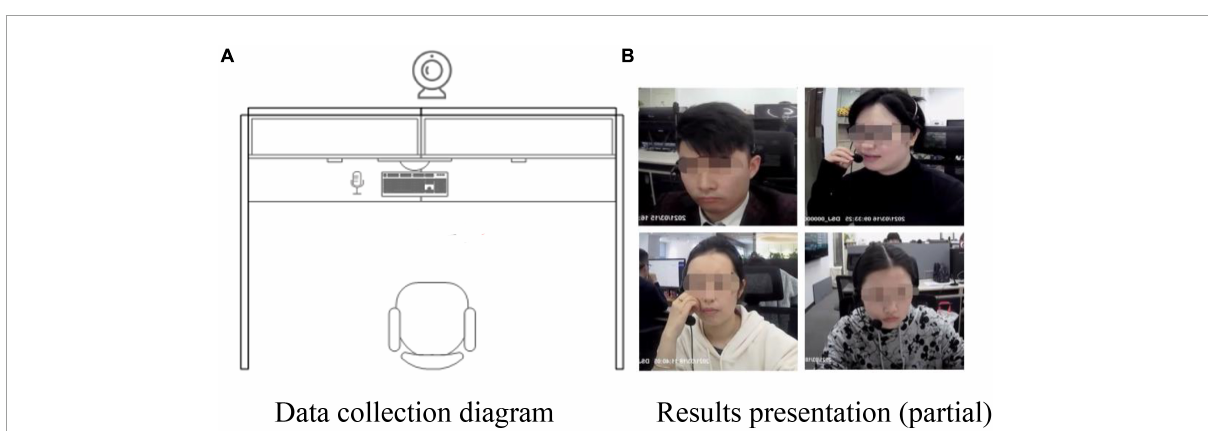
FIGURE1 Research framework.